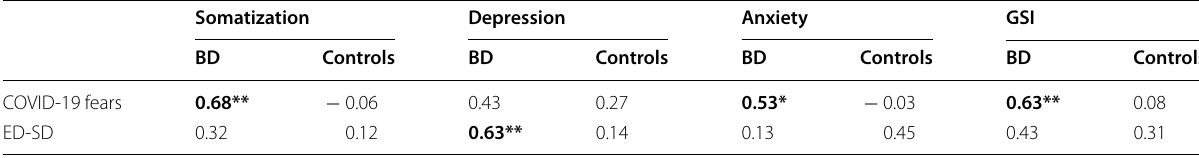
Table 6 Partial correlations between COVID‑19 fears/emotional distress due to social distancing at T1 and BSI‑18 scales at T2 in BD patients and healthy